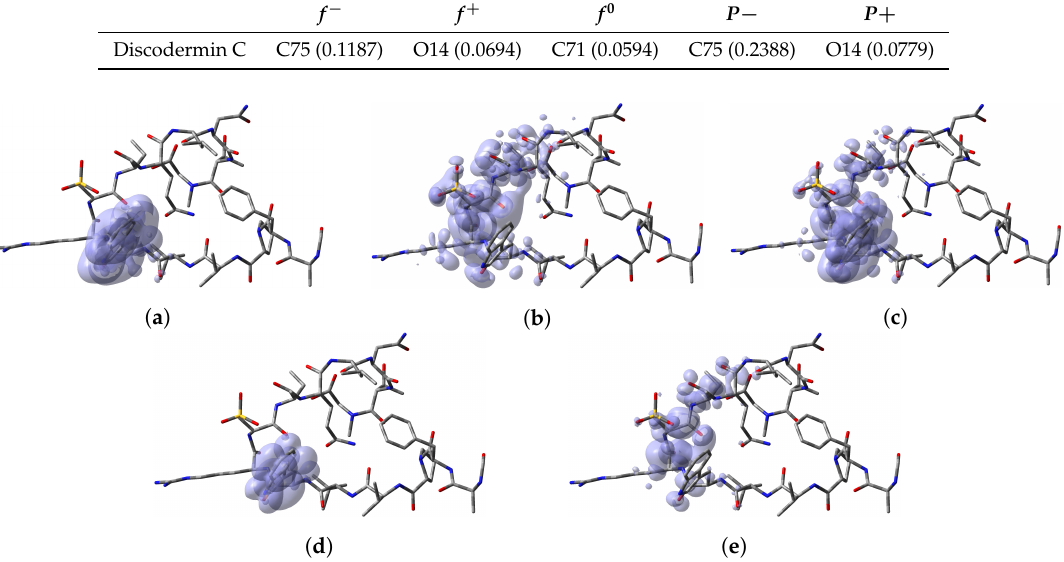
Figure A3. Graphical sketches of the local reactivity descriptors for Discodermin C showing the reactivity regions: ( a ) Electrophilic Fukui Function f − , ( b ) Nucleophilic Fukui Function f + , ( c ) Radical Fukui Function f 0 , ( d ) Electrophilic Parr Function P − and ( e ) Nucleophilic Parr Function P + . Table A4. Condensed local reactivity descriptors for Discodermin D denoting the reactivity sites: Electrophilic Fukui Function f − , Nucleophilic Fukui Function f + , Radical Fukui Function f 0 , Electrophilic Parr Function P − and Nucleophilic Parr Function P +